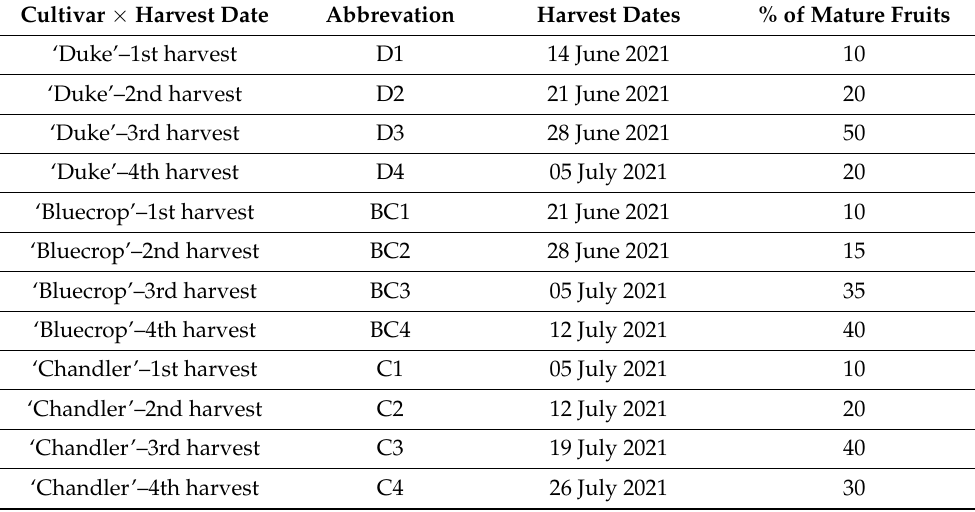
Table 1. The harvest dates and percent of mature fruits (fruits ripe for harvest) during each